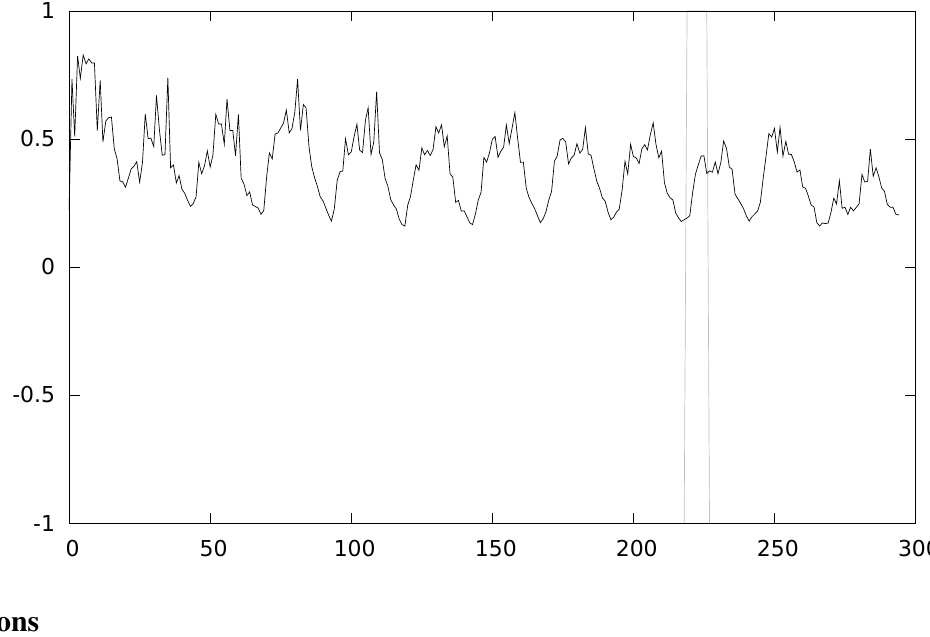
Figure 13. Correlation trace for correct key guess using windowed